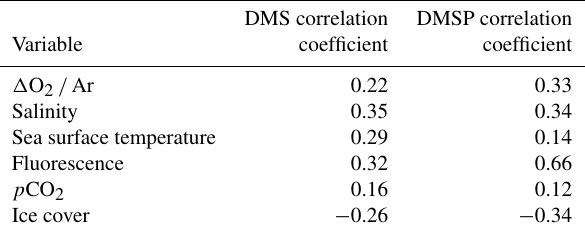
Table 4. Pearson correlation coefficients relating DMS measure- ments made by MIMS and DMSP measurements made by OSS- CAR to other oceanographic variables. Only correlations significant at the p <0.05 level are shown. (cid:49) O 2 / Ar ratios were obtained using